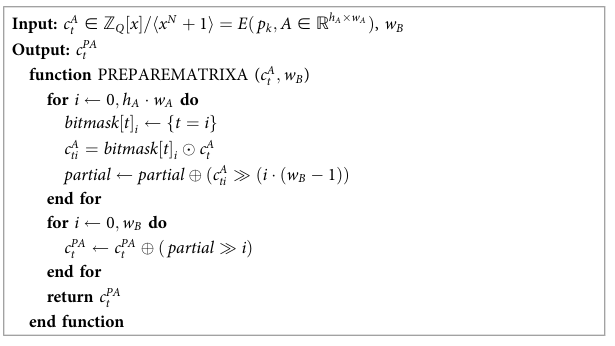
Algorithm 6 Initial Representation for Matrix A in Matrix Multiplication Algorithm 7 Initial Representation for Matrix B in Matrix Multiplication